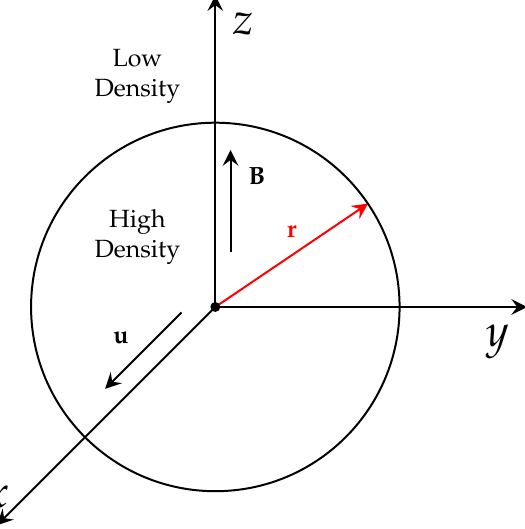
Figure 1. A diagram illustrating the geometry of a 3D plasma cloud in a background plasma with labeled axes and important vectors. The density inside the cloud is high, while the background plasma has a low density. The magnetic field is in the ˆ z (i.e., vertical) direction. The neutral wind is in the ˆ x direction (i.e., north). This configuration is unstable to the GDI on the leading edge of the cloud (i.e., along the neutral wind direction). The density was modeled using Equation